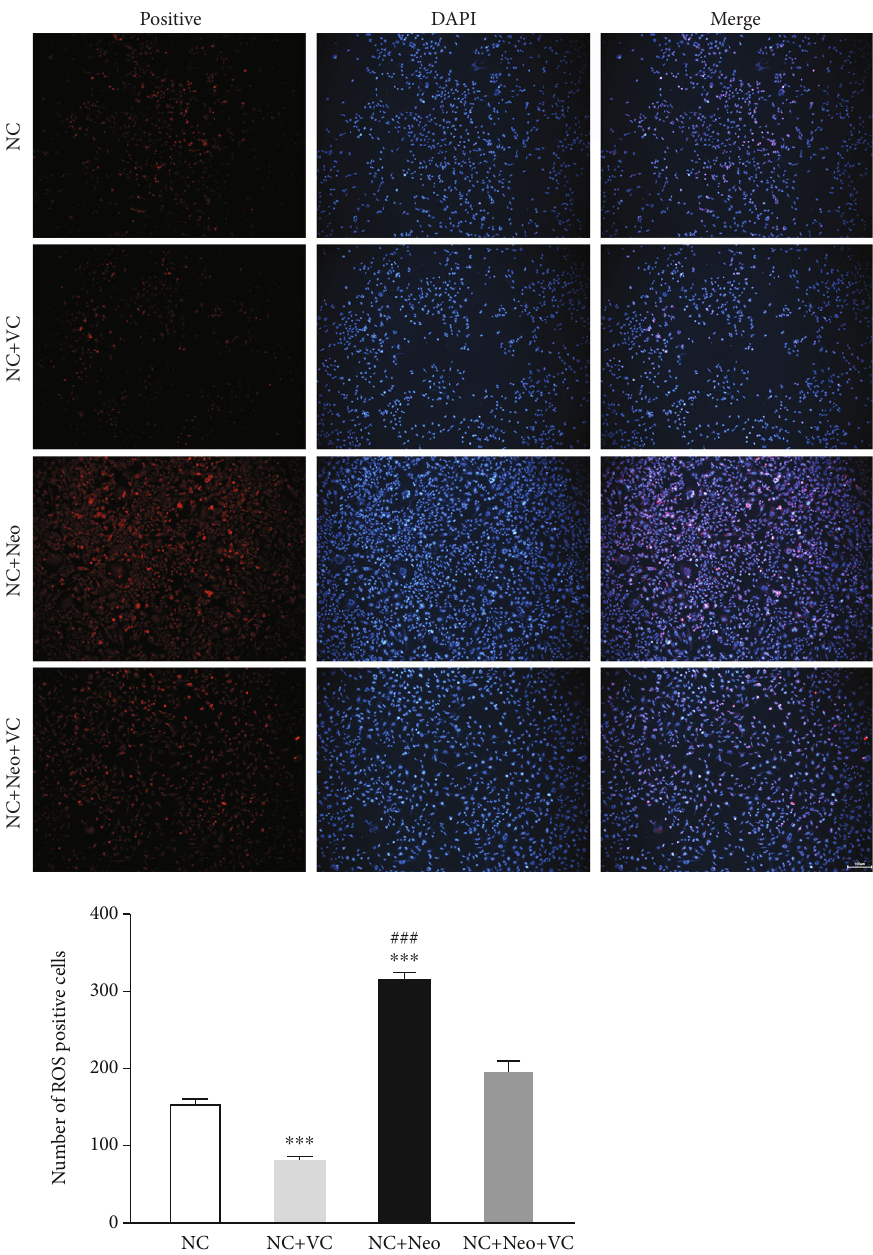
Figure 5: Expression of ROS on neomycin and VC-treated HEI-OC1 cells. ROS of HEI-OC1 cells was detected by DCFH-DA staining. The ROS-positive staining is red, scale bar = 100 μ m. The expression of staining on normal control cells, VC-treated cells, neomycin-treated cells, VC, and neomycin-cotreated cells. The number of ROS-positive staining cells with neomycin and VC treatment. One-way ANOVA, ∗∗∗ p < 0 : 001 versus NC group and ### p < 0 : 001 versus NC+Neo+VC group. All tests were repeated three times